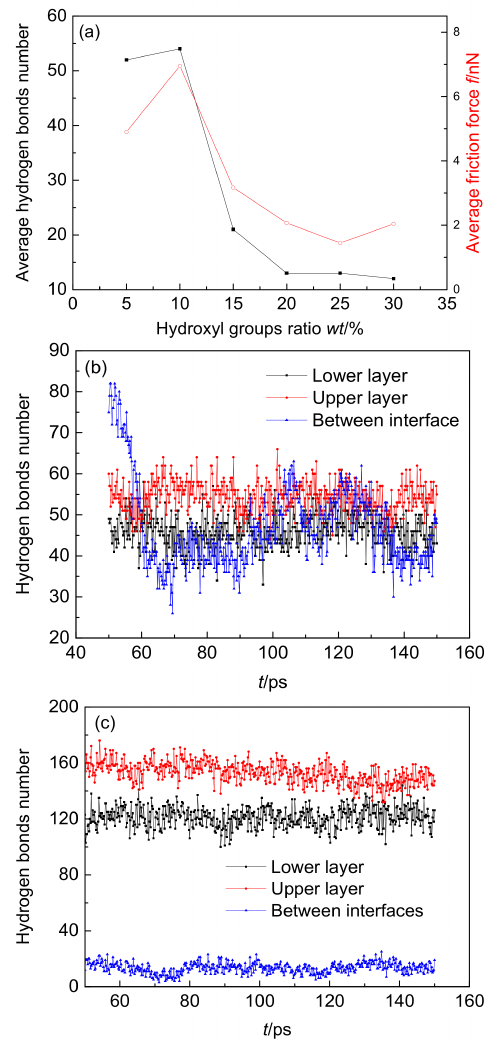
Figure 3. ( a ) The average hydrogen bonds number between interfaces and the average friction force during motion stage in six cases with hydroxyl groups ratios of 5%/5%, 10%/10%, 15%/15%, 20%/20%, 25%/25% and 30%/30%; ( b ) The hydrogen bonds number in the lower graphene layer, the upper graphene layer and between interfaces in the case with hydroxyl groups ratio 5%/5%; ( c ) The hydrogen bonds number in the case with hydroxyl groups ratio